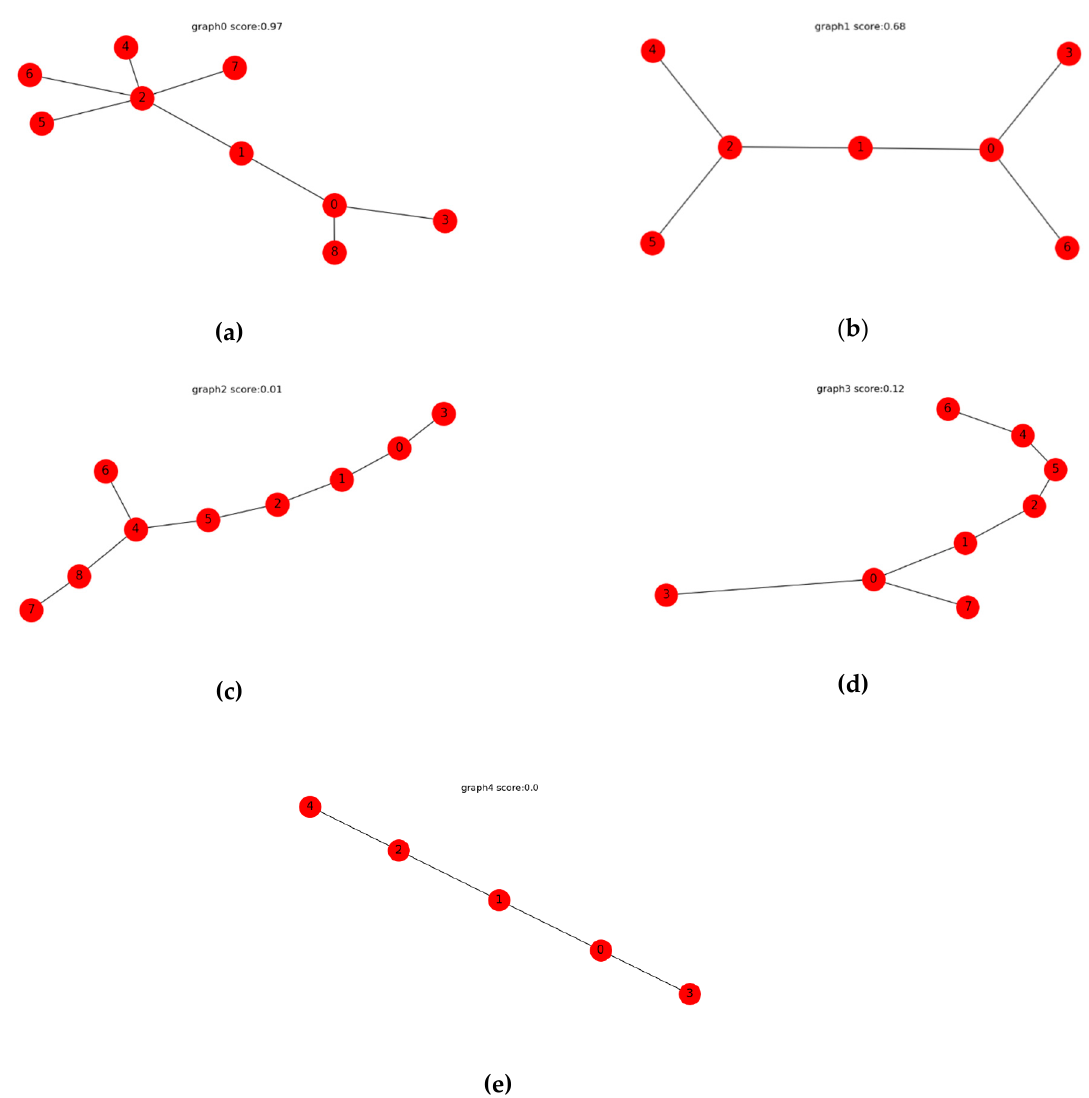
Figure 5. The designer community candidate set. ( a ) Designer network graph 1, ( b ) Designer network graph 2, ( c ) Designer network graph 3, ( d ) Designer network graph 4, ( e ) Designer network graph 5